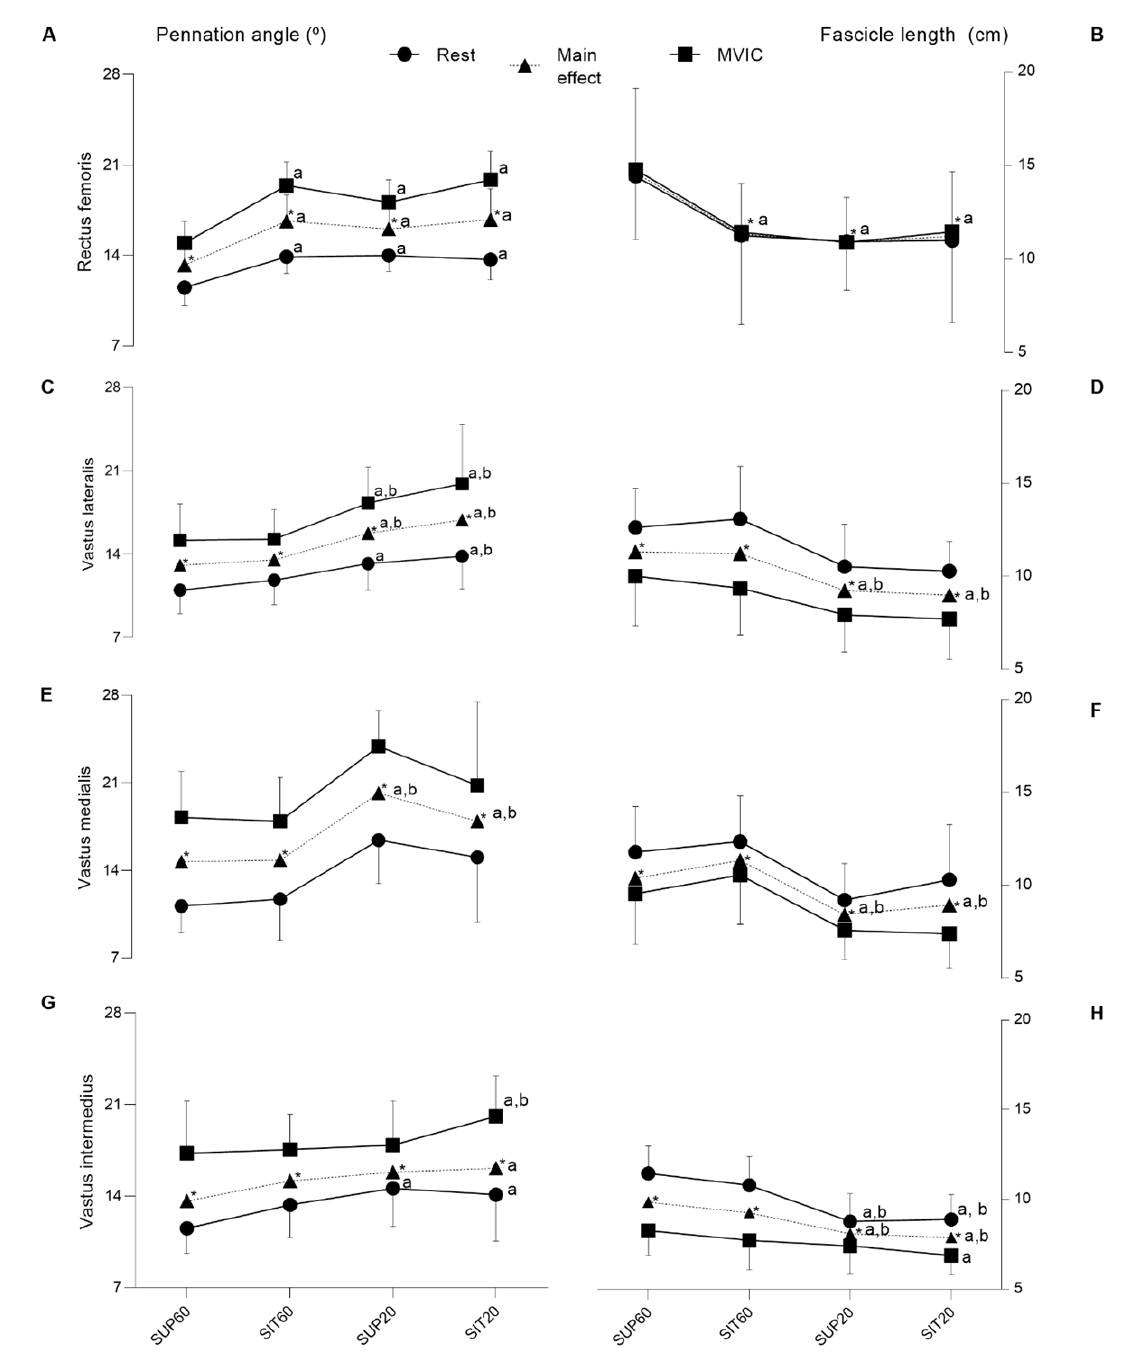
Figure 5. The pennation angle and fascicle length of the quadriceps femoris constituents according to hip and knee angles during rest and contraction. Muscle (left y -axis) and different conditions (right x -axis). Rest (closed circle line), main effect (closed triangle line) and during MVIC (closed square line). The first column (pennation angle —θp (°) and secon d column (fascicle length — Lf (cm)). Data are presented as means and confidence intervals (CI 95%). ( A , B ) Rectus femoris; ( C , D ) Vastus lateralis; ( E , F ) Vastus medialis; ( G , H ) Vastus intermedius. Legend: SUP60: supine with 60° of knee flexion; SIT60: seated with 60° of knee flexion; SUP20: supine with 20° of knee flexion; SIT20: seated with 20° of knee flexion; θp: pennation angle; Lf: fascicle length. Significant differences: a different from SUP60 at ( p ≤ 0.05 ); b different from SIT60 ( p ≤ 0.05); * indicate significant differences in intensity ( p ≤ 0.05) between rest and MVIC.